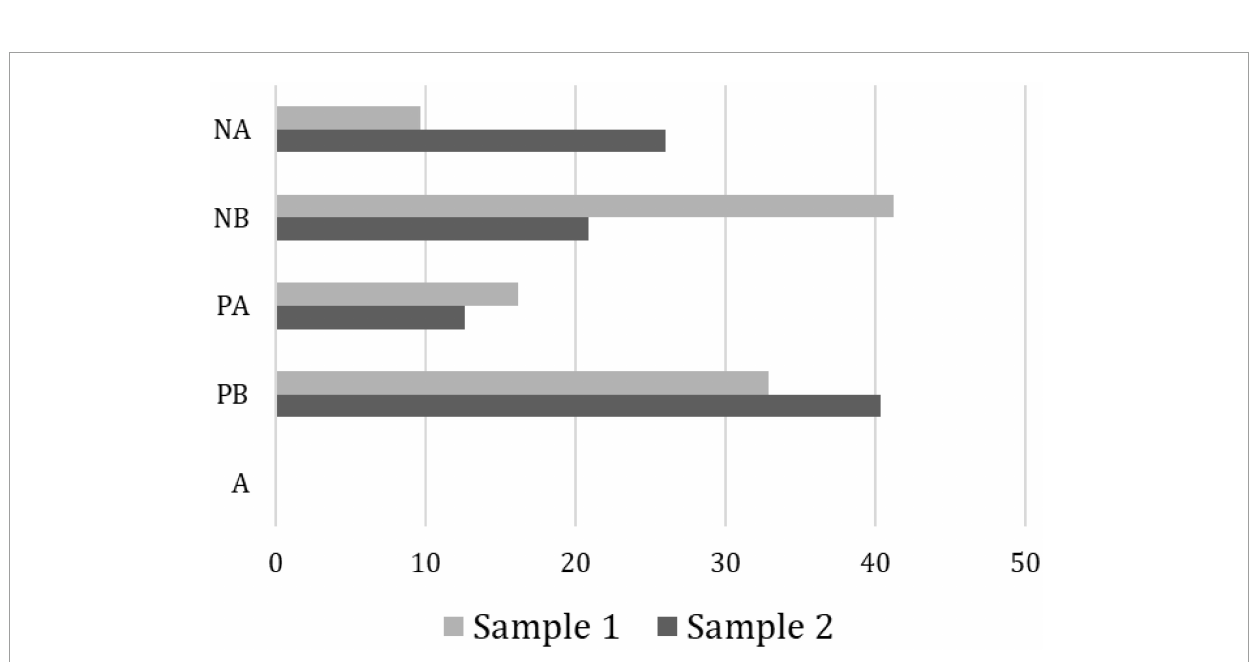
FIGURE11 Comparison between samples 1 (1–4 A) and 2 (1–4 B) of more natural